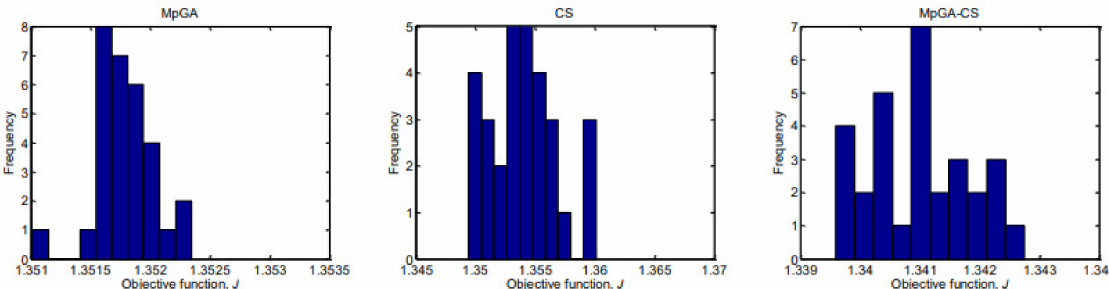
Figure 9. Histograms of the results of objective function values from parameter identification of S. cerevisiae FP model (30